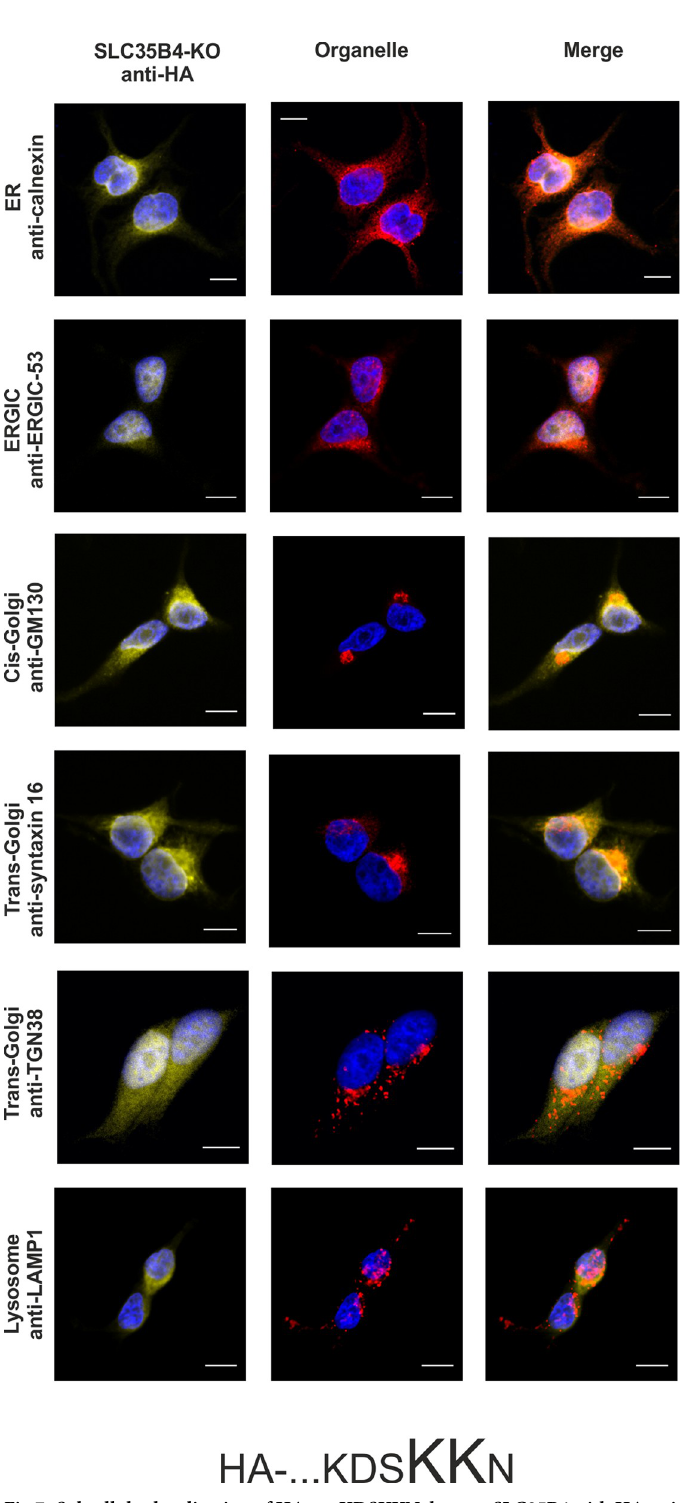
Fig 7. Subcellular localization of HA- ... KDSKKN, human SLC35B4 with HA-epitope at the N-terminus in the knock-out HepG2 cells. Stably transfected cells, lacking functional SLC35B4 gene (SLC35B4-KO), overexpressing SLC35B4 variants, were subjected to indirect immunofluorescent staining with anti-HA (green) and anti-organelle markers (Table 3) (red) antibodies. Cell nuclei were counterstained with DAPI. Scale bar 10 μ m.